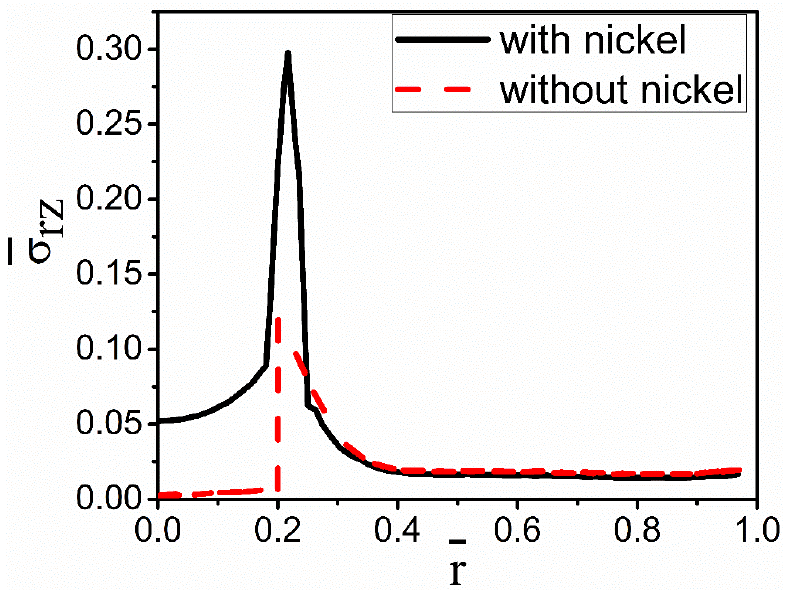
Figure 9. Radial changes in von Mises stress with and without nickel coating z(cid:3364) = 0.1.